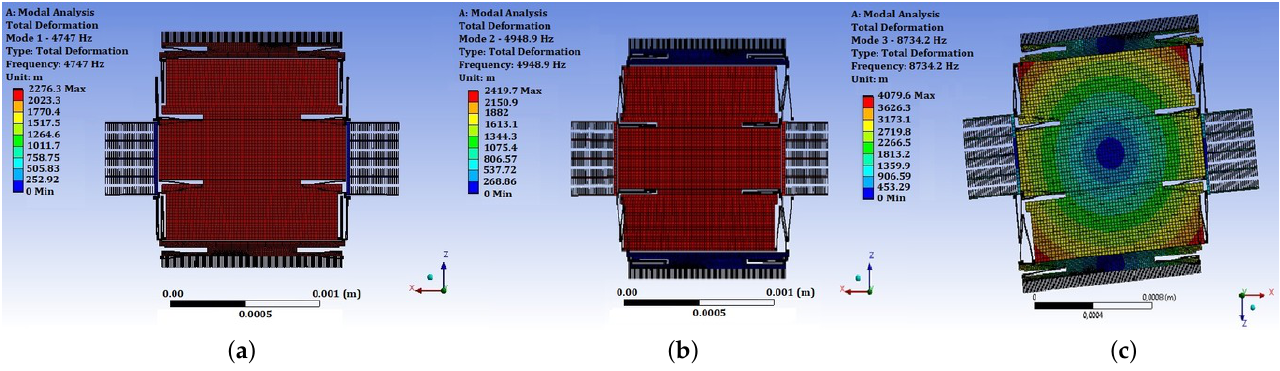
Figure 18. Modes of oscillation of the SE of the MEMS gyroscope: ( a ) the first oscillation mode; ( b ) the second oscillation mode; ( c ) the third oscillation